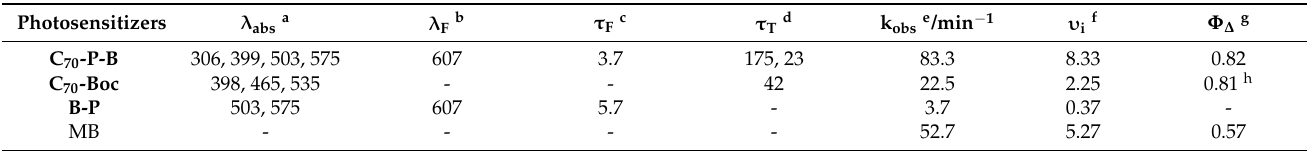
Table 1. The photophysical properties of the